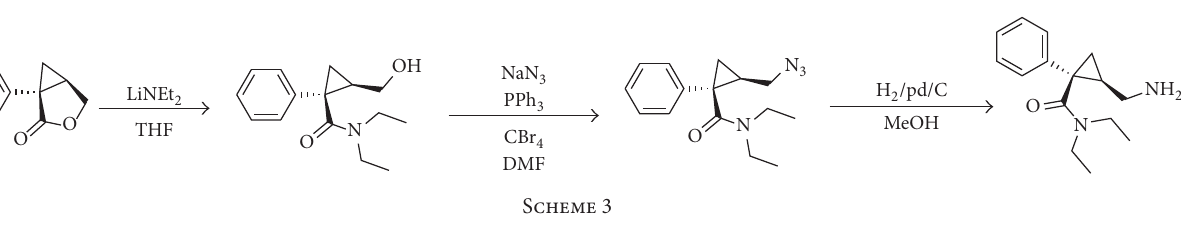
Scheme 2: Reductive amination of